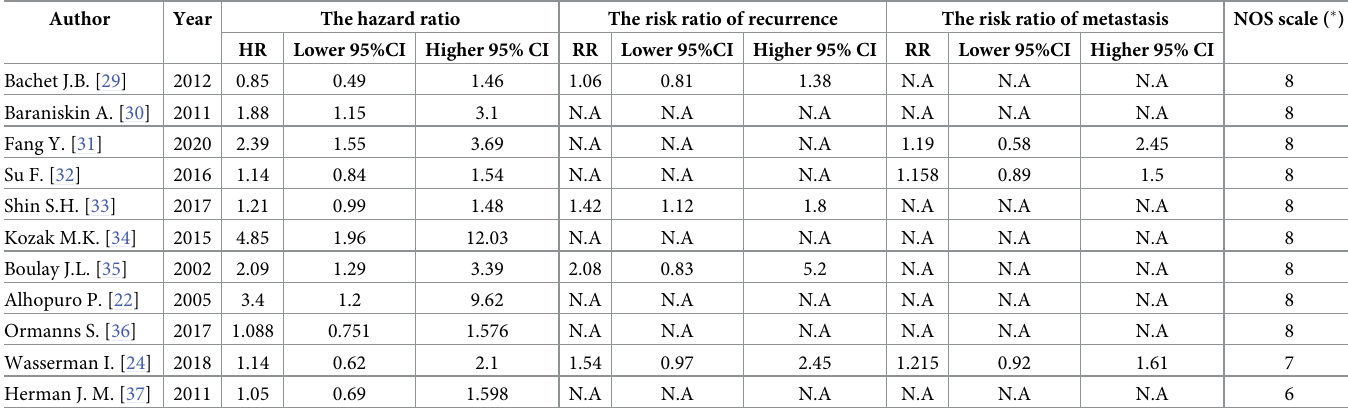
Table 2. The statistical data and quality assessment of